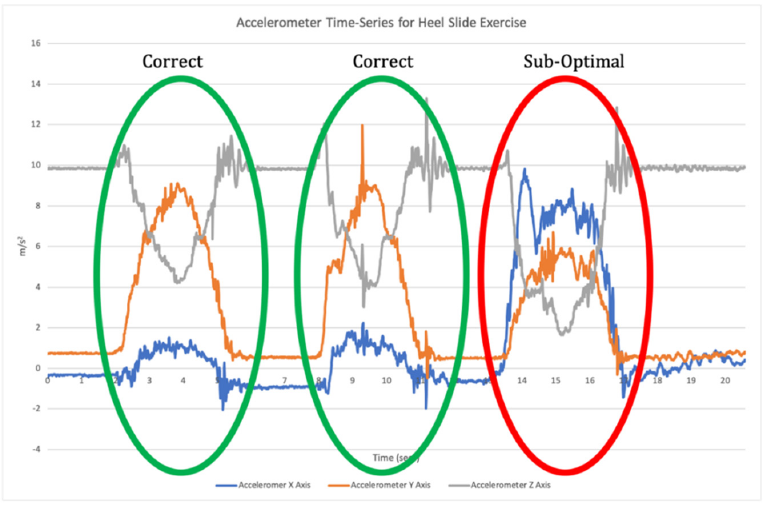
Figure 2. An example of classification of a time-series of triaxial accelerometer data with a sub-optimal repetition highlighted in red.